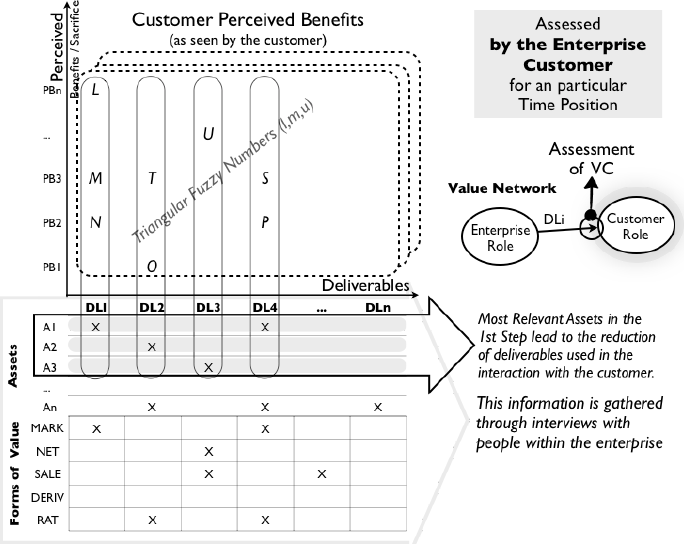
Fig. 3. Customer Perceived Value assessed by the Enterprise Customers for a particular Time Position